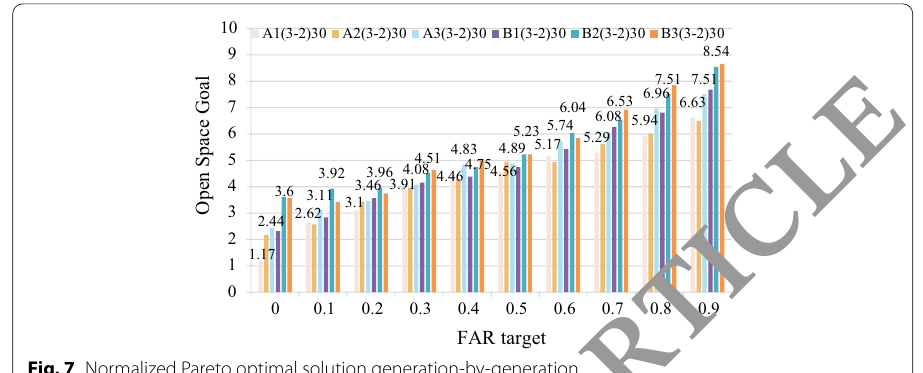
Fig. 7 Normalized Pareto optimal solution